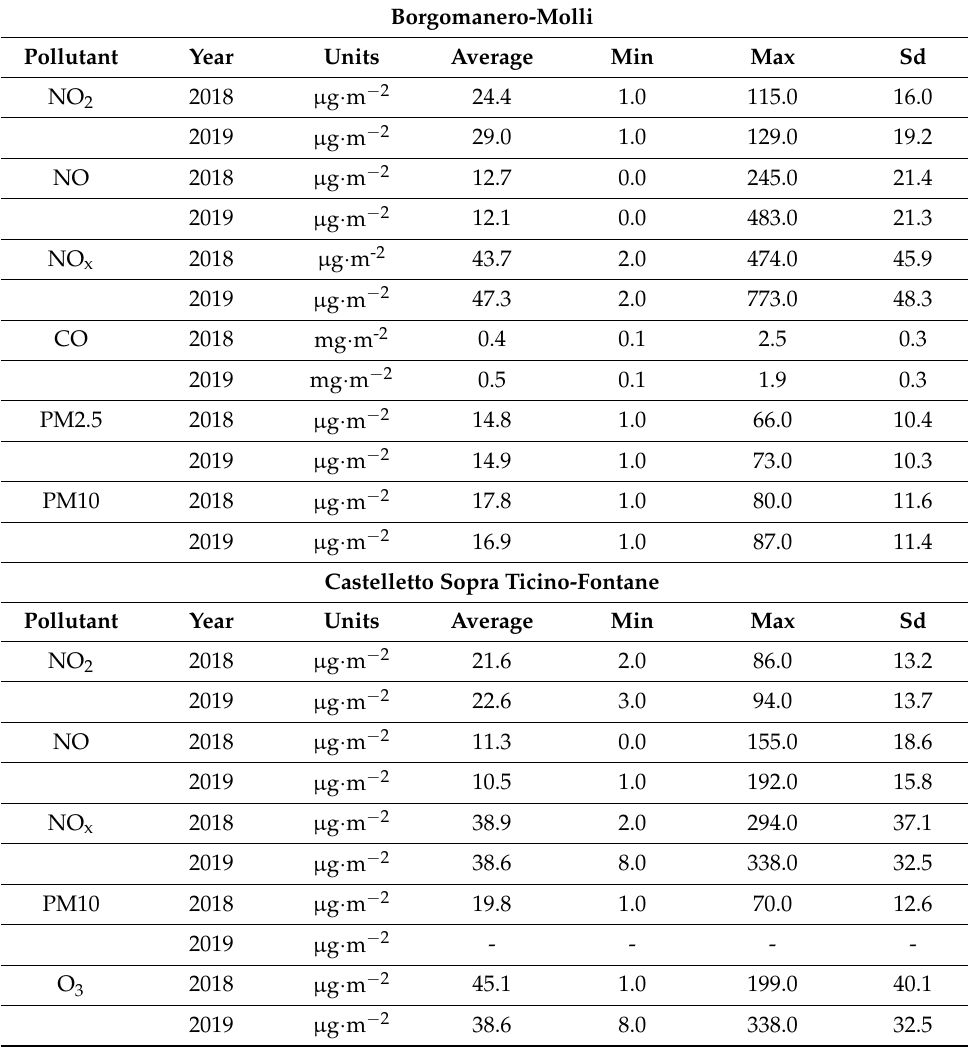
Table 1. Average pollutants concentrations: data obtained from the monitoring station near Arona (from the regional environmental protection agency (ARPA)